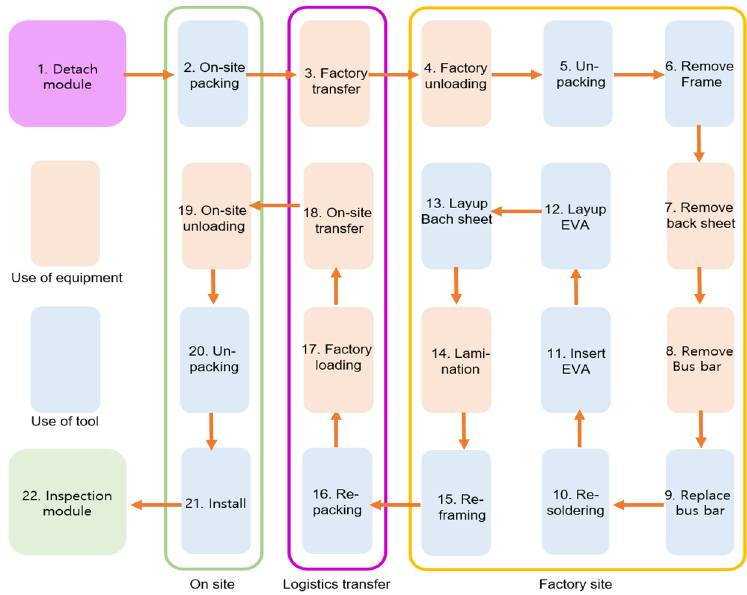
Figure 14. Factory recovery process for RSB hotspot PV module.